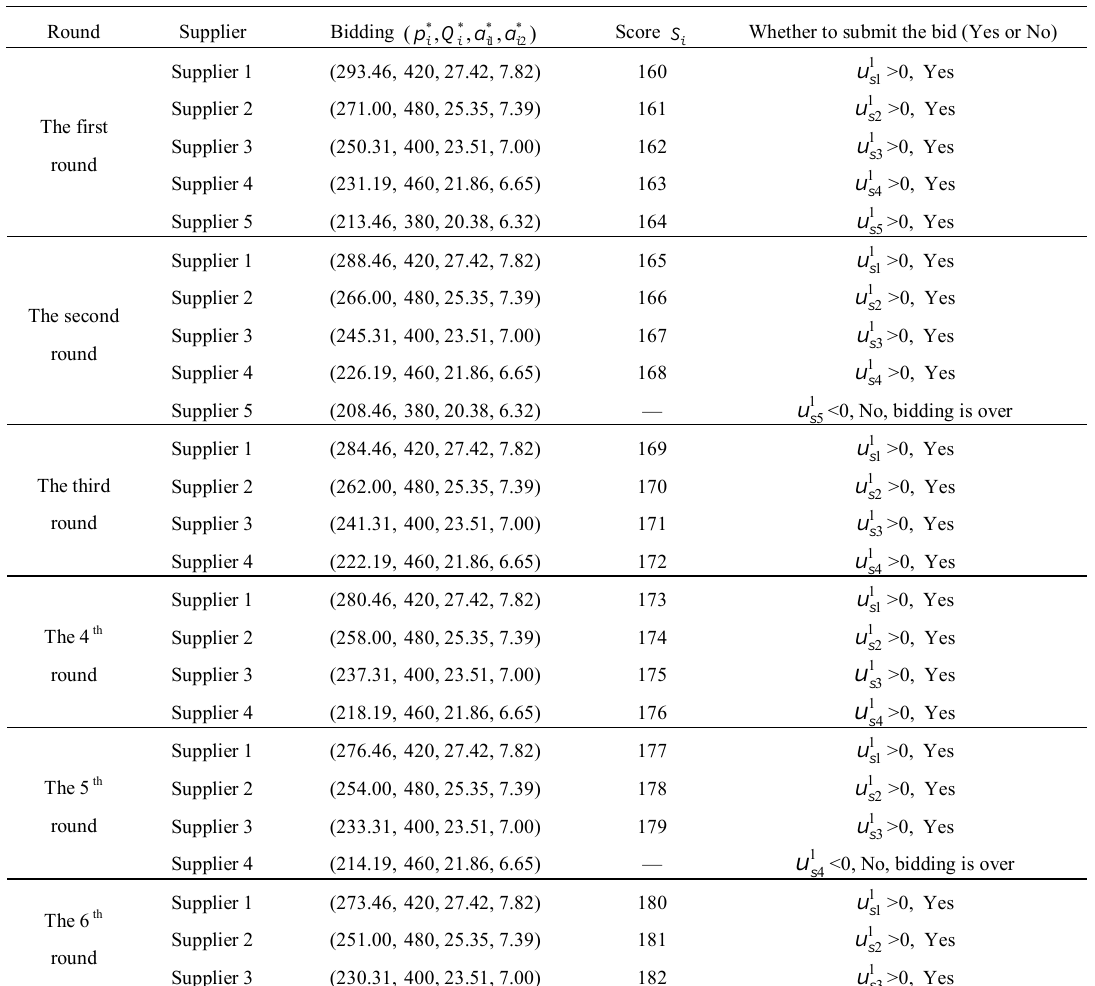
Table 1. The simulation results of the overall